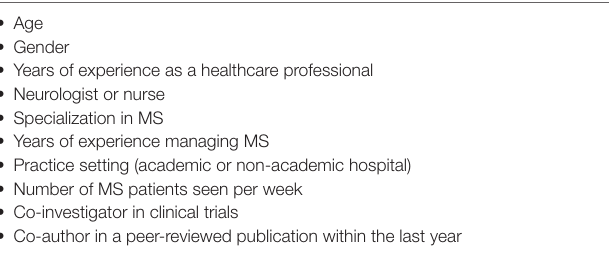
TABLE 1 | Socio-demographic characteristics, professional background, and practice setting.